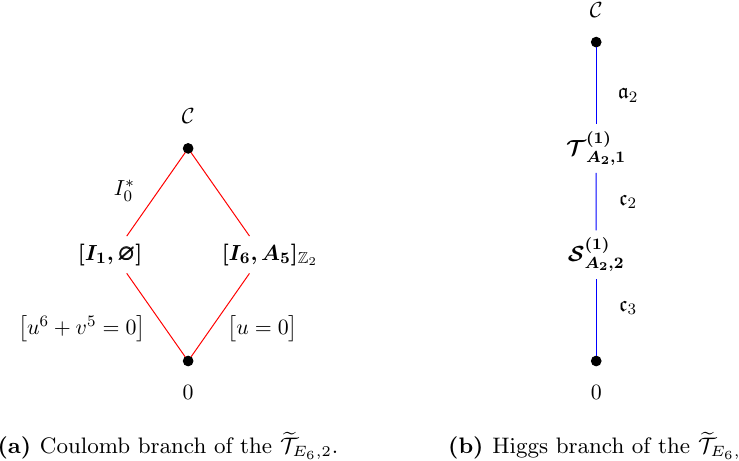
Figure 13. The Coulomb (a) and Higgs (b) strati(cid:12)cation of e T E